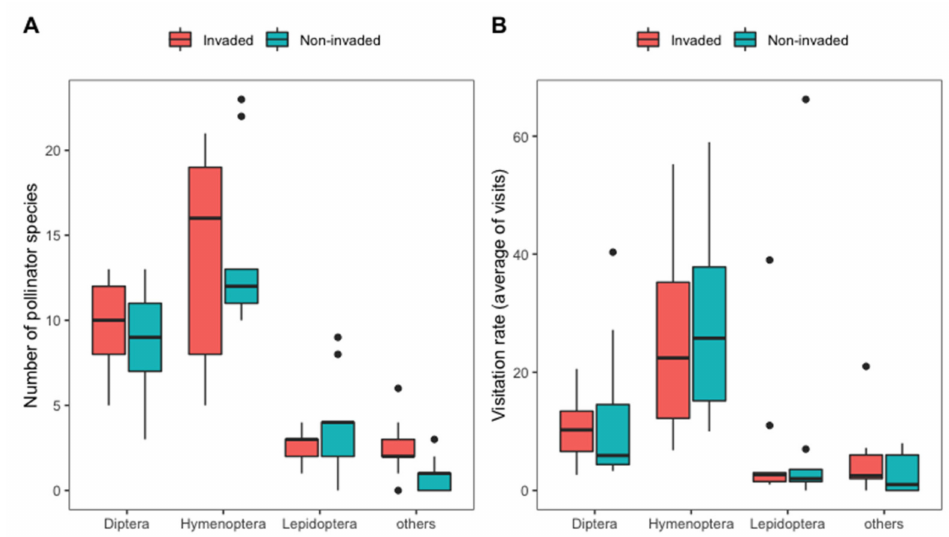
Figure 1. Pollinator richness ( A ) and visitation rates ( B ) from four insect groups (Diptera, Hy- menoptera, Lepidoptera, and other arthropods) within the invaded and non-invaded sites.